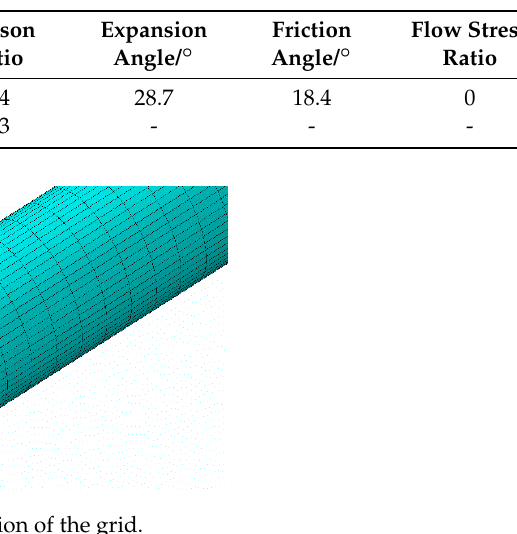
Figure 5. Comparison of stress at the middle of the pipeline. Figure 6. Comparison of stress at the end of the pipeline. As mentioned above, when analyzing the maximum stress value and middle stress value of the pipeline, the nonuniform excitation stress value is larger than the uniform excitation stress value, which indicates that it is necessary to take into account the influence of spatial variation on the earthquake response of long-distance pipeline. The stress value of nonuniform noncontinuous configuration is larger than the nonuniform stimulus, which further reflects the spatial effect. However, at the end of the pipeline, the stress values for the three conditions are not substantially different. These results show that if the pipeline is a “point” structure, there is no spatial influence of the loads. 7. Fuzzy Damage Analysis of the Pipeline